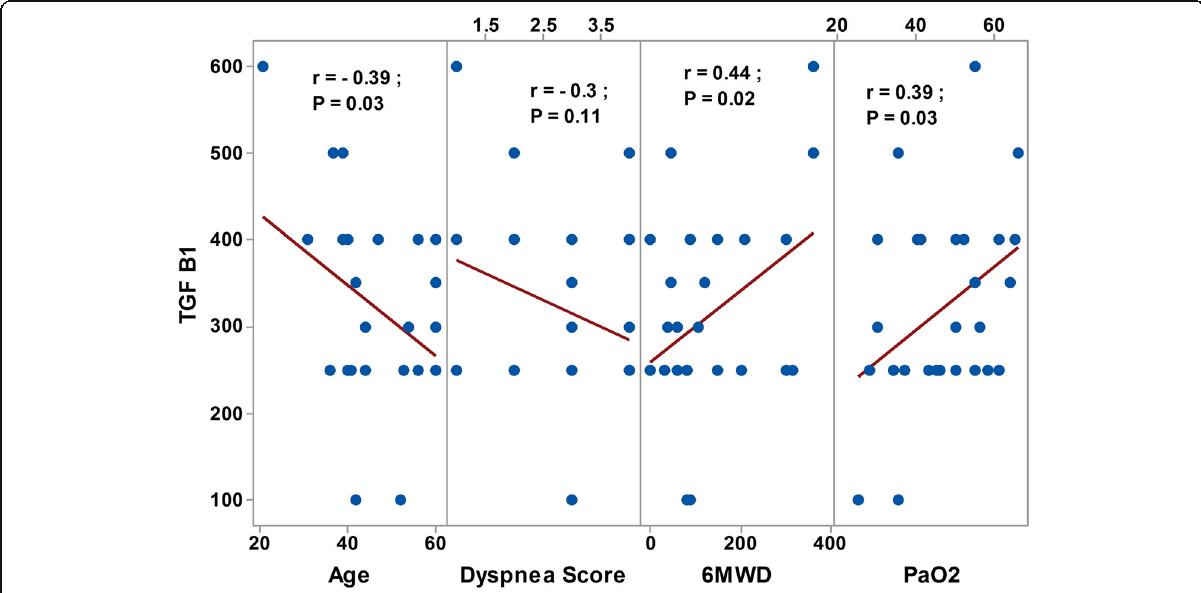
Fig. 3 Correlation between serum levels of TGF β 1 with the clinical data and PaO 2 : a . Age. b . Dyspnea score. c . 6- MWD. d . P a O 2